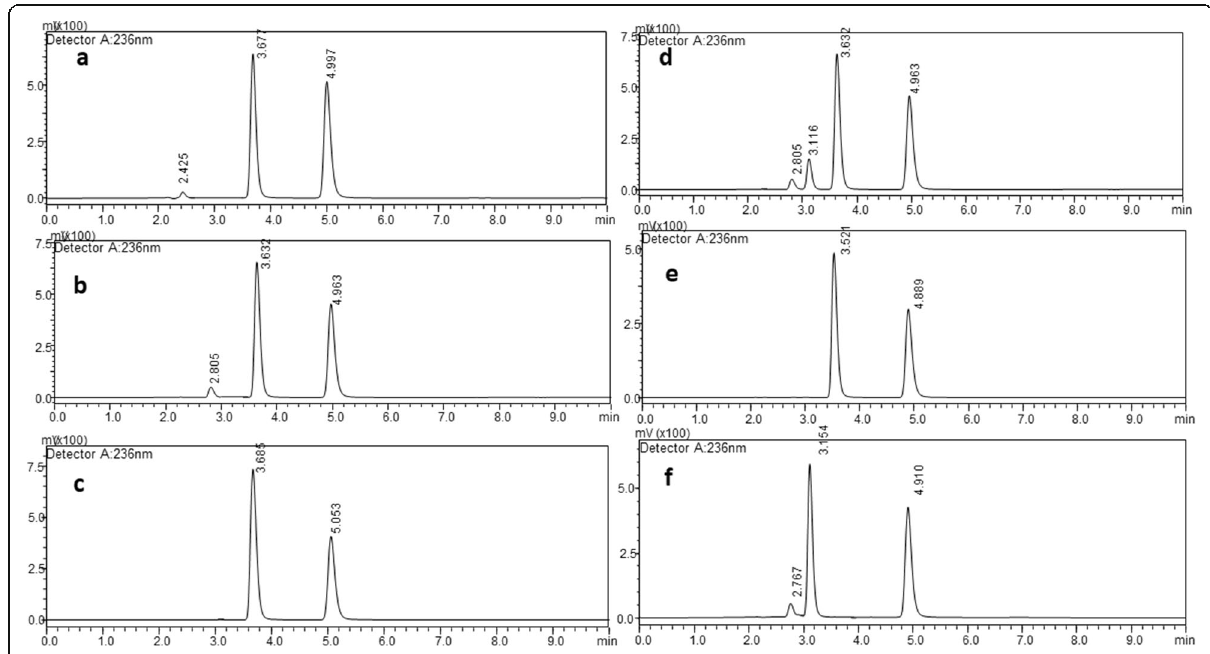
Fig. 6 Contour plots of optimized method for responses: ( a ) resolution; ( b ) dapagliflozin capacity factor; ( c ) saxagliptin capacity